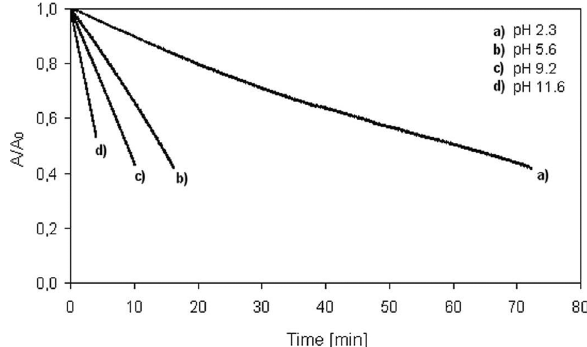
Fig. 4 Interfacial film stability (at constant surface pressure) of tetraacid at different pHs (Brandal et al. 2006). [ A / A 0 ] is the loss in interfacial area